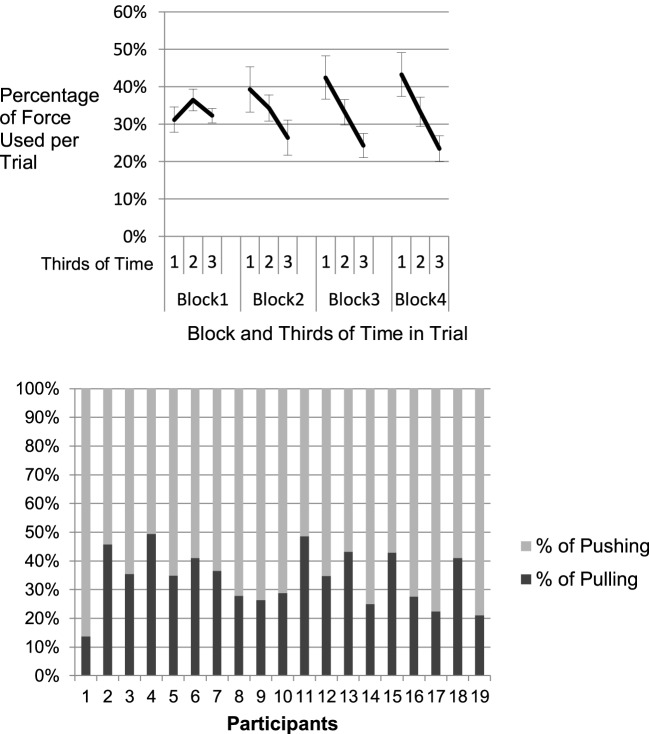
Use of force within trials and across blocks of practice (upper panel): The x-axis displays thirds of time per trial on the four blocks. The y-axis shows the percentage of force used on the thirds averaged over all trials of the block, as each block accounts for 100%. The decline of force with proceeding trial-time illustrates the strategy change from constant pushing and pulling in the first block to a more initial use of force at the beginning of the trial. Lower panel: All participants show a strong use of pushing, no participant uses pulling as the dominant (>50%) strategy.